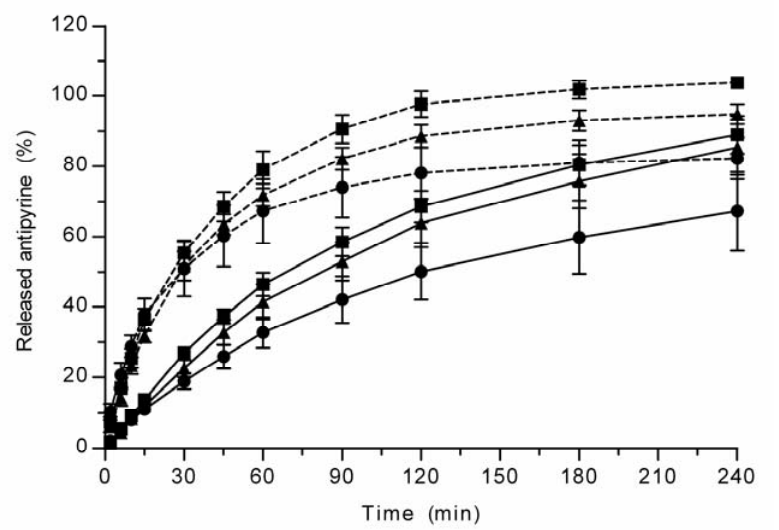
Figure 4. Antipyrine release from TCPSi microparticles ( ● ), or the transport of antipyrine applied either as a powder ( ▲ ) or a solution ( ■ ) into the acceptor chamber across the polyester (solid line) or polycarbonate (dashed line) membranes using the well-plate method. Mean ± SD values are shown (n =